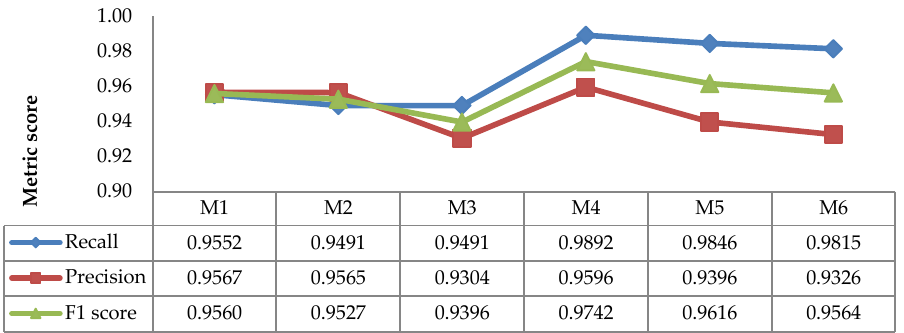
Figure 17. Average recall, precision, and F1 scores of Ara2013. Table 4. Comparison of leaf detection performance. Method (Ref.)